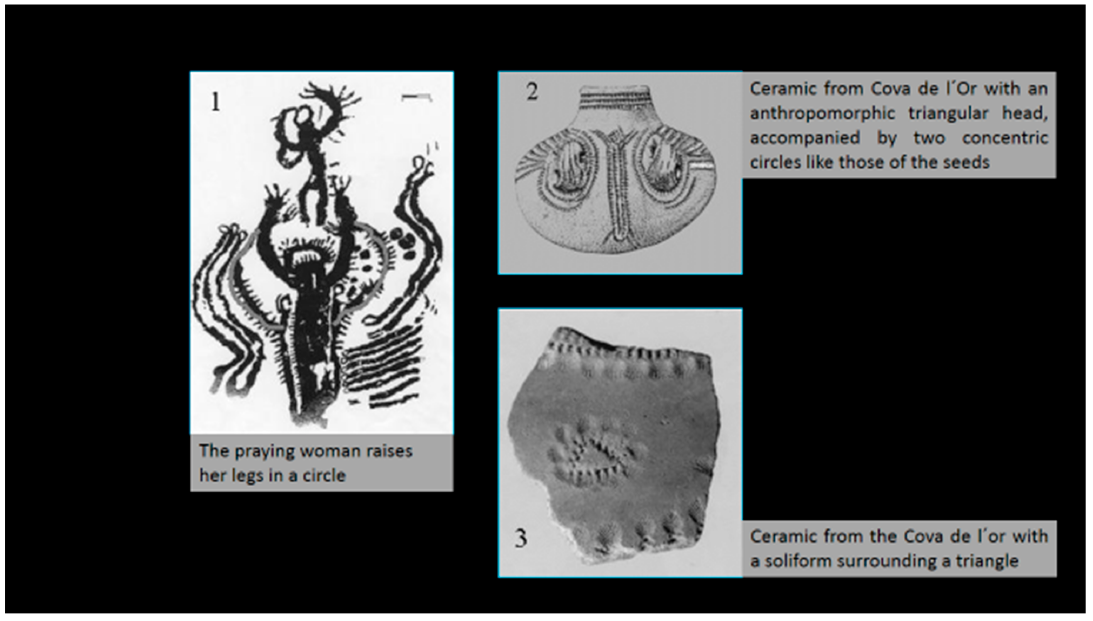
Figure 22. The circle and the sun in 3.